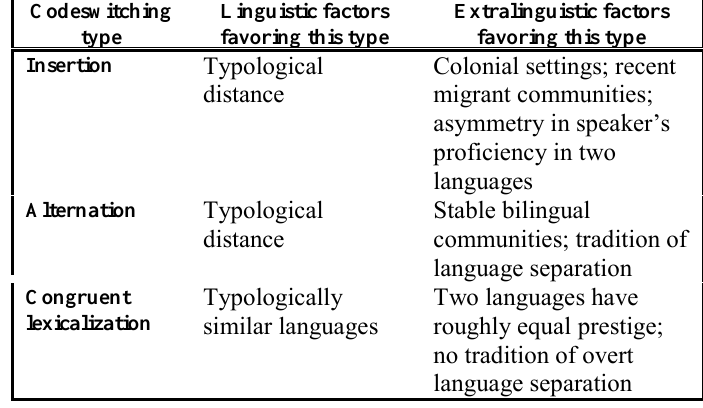
Table 1: From Deuchar, Muysken, and Wang (2007: